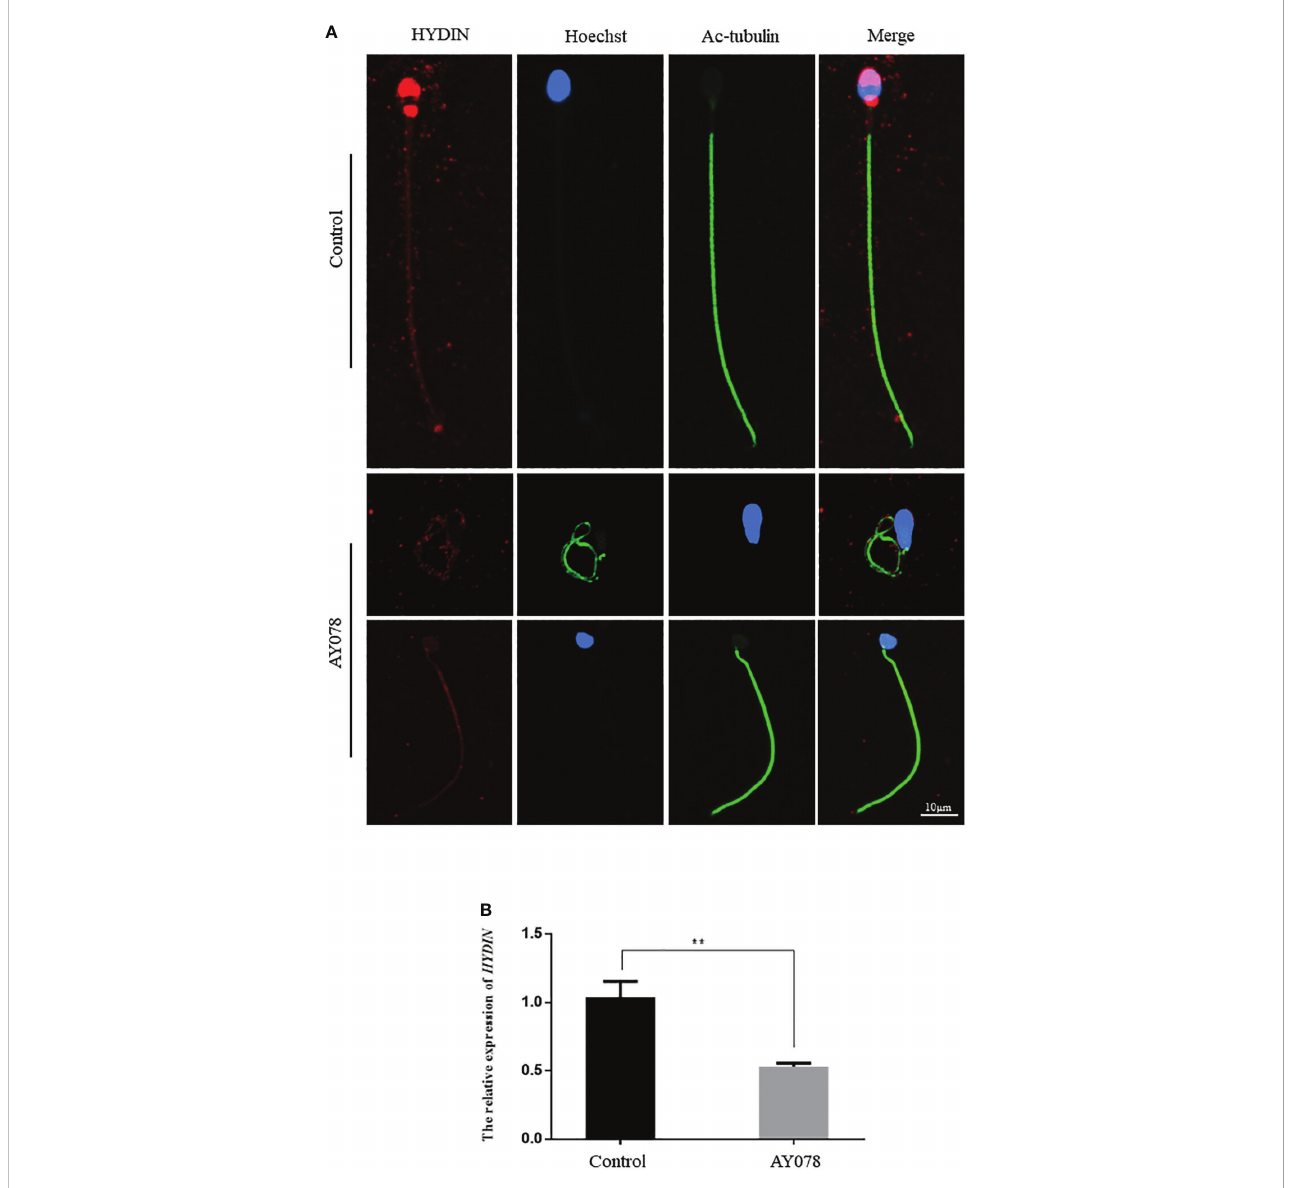
FIGURE 4 The IF and RT-qPCRassays in patient AY078 and fertile individuals. (A) IF analysis of HYDINin sperm fromcontrol man and AY078. Inthe fertileindividual, signals of HYDIN localized along the sperm fl agella, besidesthis, wereclear found in the neck and anterior head(acrosome). By contrast,the HYDINstainingwas dramatically reduced or absent inspermof P1 harboring HYDIN variants. Scalebar:10 m m. (B) The relative mRNAexpression level of HYDIN in AY078 and control individual. The HYDINmRNA level ofHYDIN-de fi cient subjects was signi fi cantly reduced compared with that inthe control.**P <